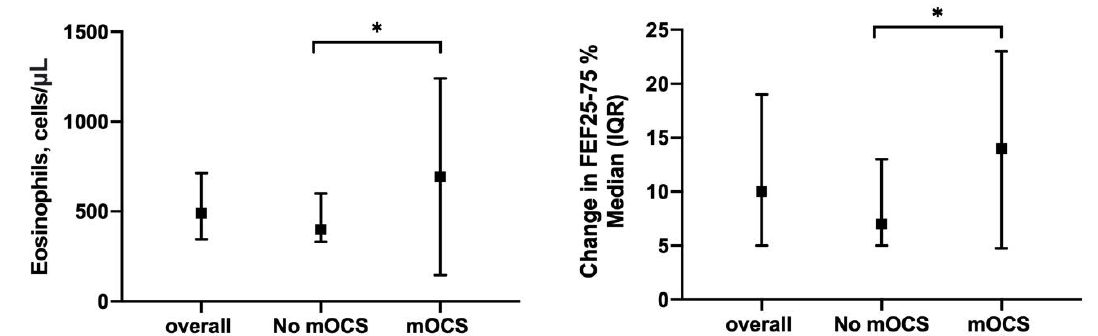
Figure 7. Sub-analysis of patients clustered upon need for maintenance oral corticosteroids (mOCS): ( Left ) shows baseline blood eosinophil counts between No-mOCS and OCS subgroups; ( Right ) shows change in FEF25-75% median after 12 months of treatment in the same subgroups (*: p < 0.05).